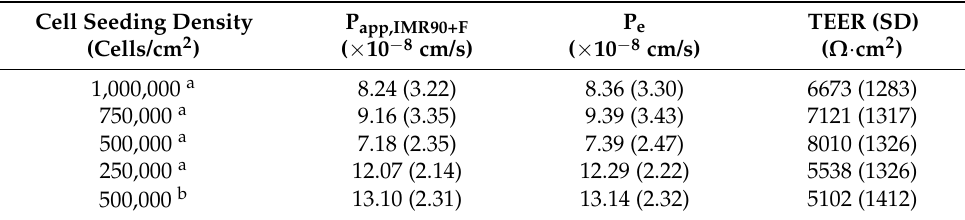
Table 1. Paracellular permeability of sodium fluorescein. Permeability (P) is presented as the mean (SD) of at least three independent experiments with